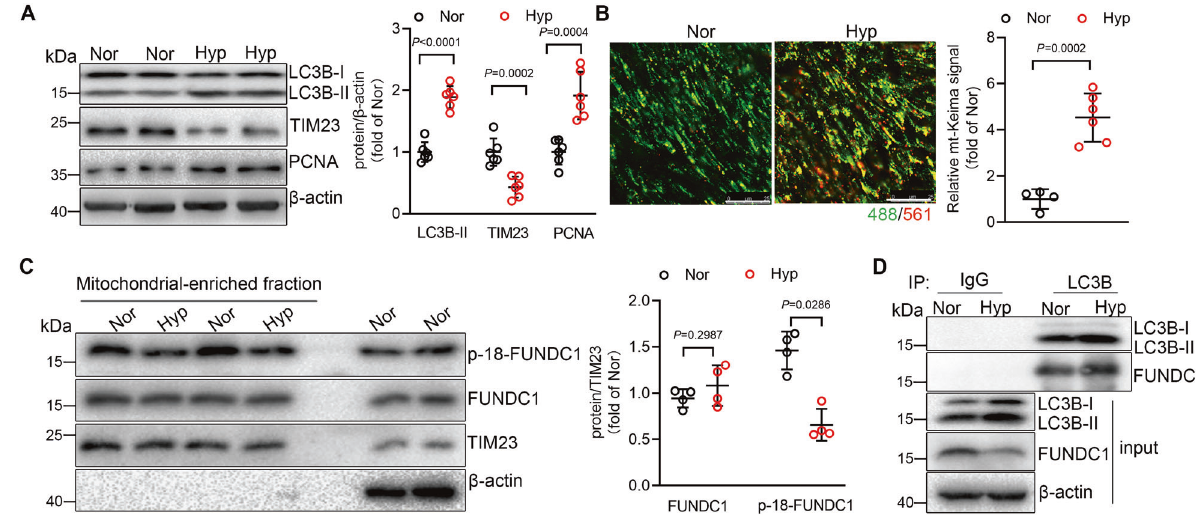
Fig. 1 Hypoxia upregulates mitophagy in pulmonary arteries from pulmonary hypertension (PH) mice and in pulmonary artery smooth muscle cells (PASMCs). A Western blot of lung tissues isolated from normoxic (21% O 2 ) or hypoxic mice (10% O 2 ) using antibodies as indicated. n = 6 mice per group. B Confocal images of median layers of pulmonary arteries from mt-Keima mice treated with normoxia or hypoxia. Values are normalized to normoxic level of mitophagy. n = 4 – 6 mice per group, scale bar: 25 μ m. C Western blot showing protein levels of p-18-FUNDC1 and FUNDC1 in mitochondria-enriched fraction from PASMCs under normoxia or hypoxia. n = 4 independent experiments per group. D Co-IP of LC3B with FUNDC1 in PASMCs with or without hypoxia treatment. Data are presented as mean ± SD. In A , B , data were analyzed using Mann – Whitney U -test. In C , p values were determined by one-way ANOVA followed by Bonferroni post hoc